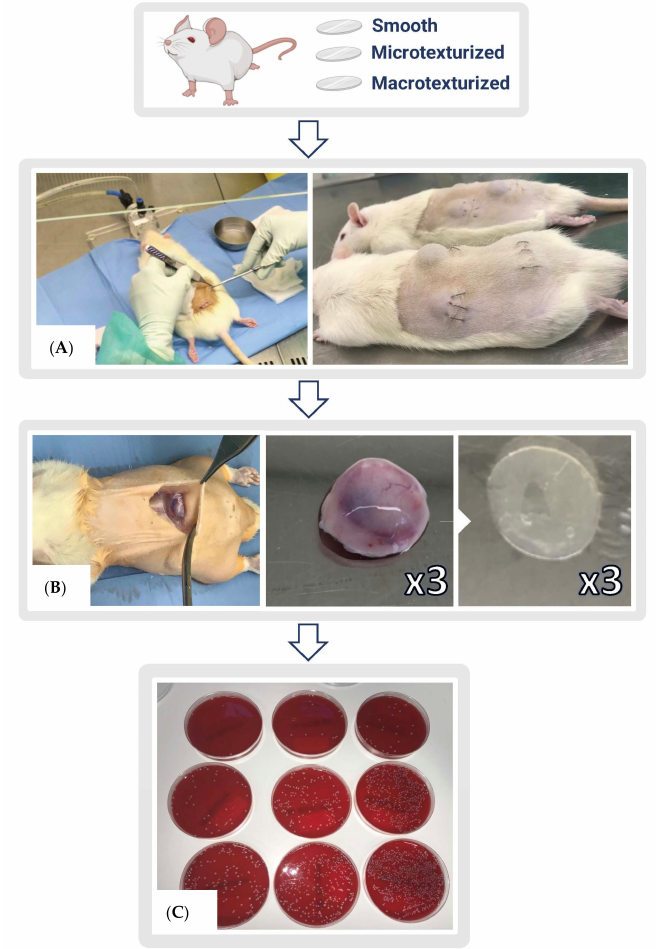
Figure 1. ( A ) Colonized implants were embedded in a laminar air flow cabinet under standard operating theatre conditions. Three 1 cm-long incisions were made, implants were placed in